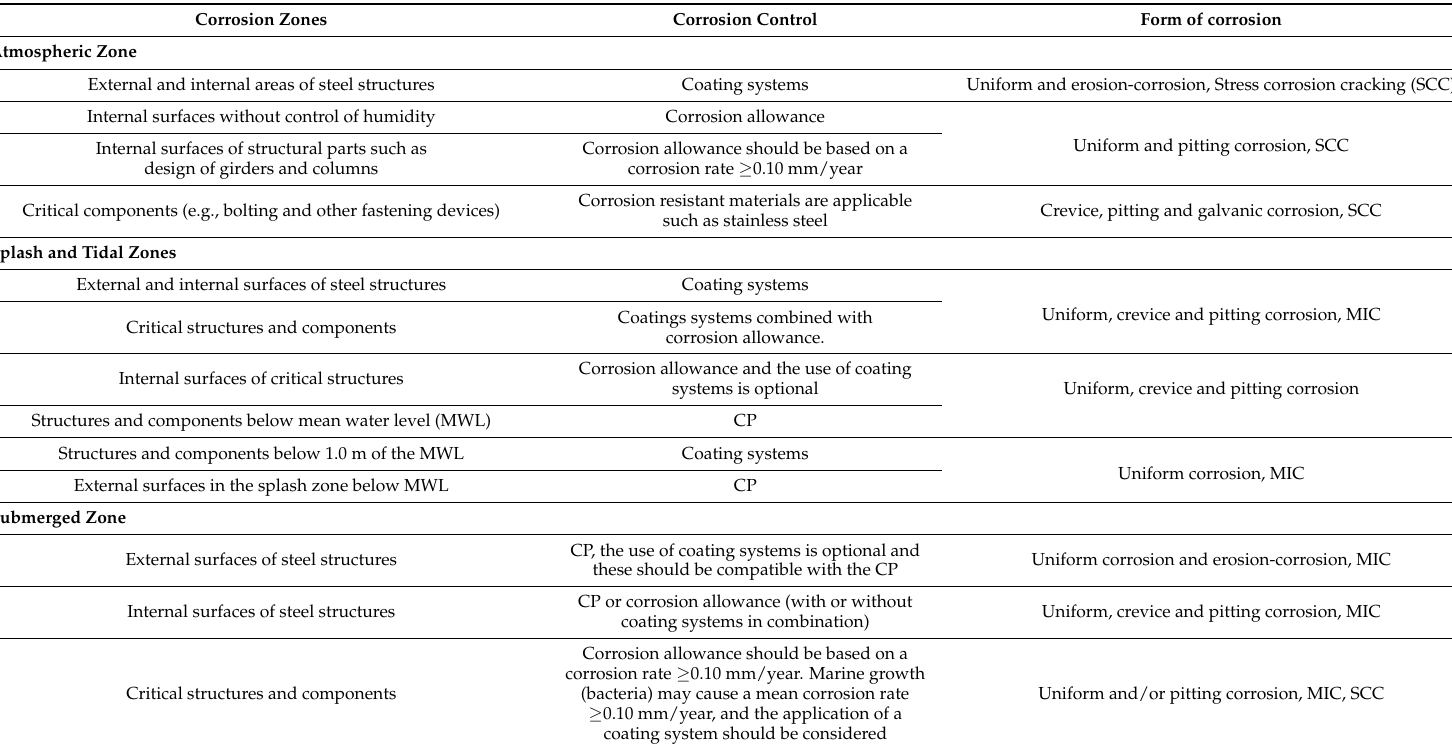
Table 4. Corrosion zones, methods for corrosion control and forms of corrosion in OWSs